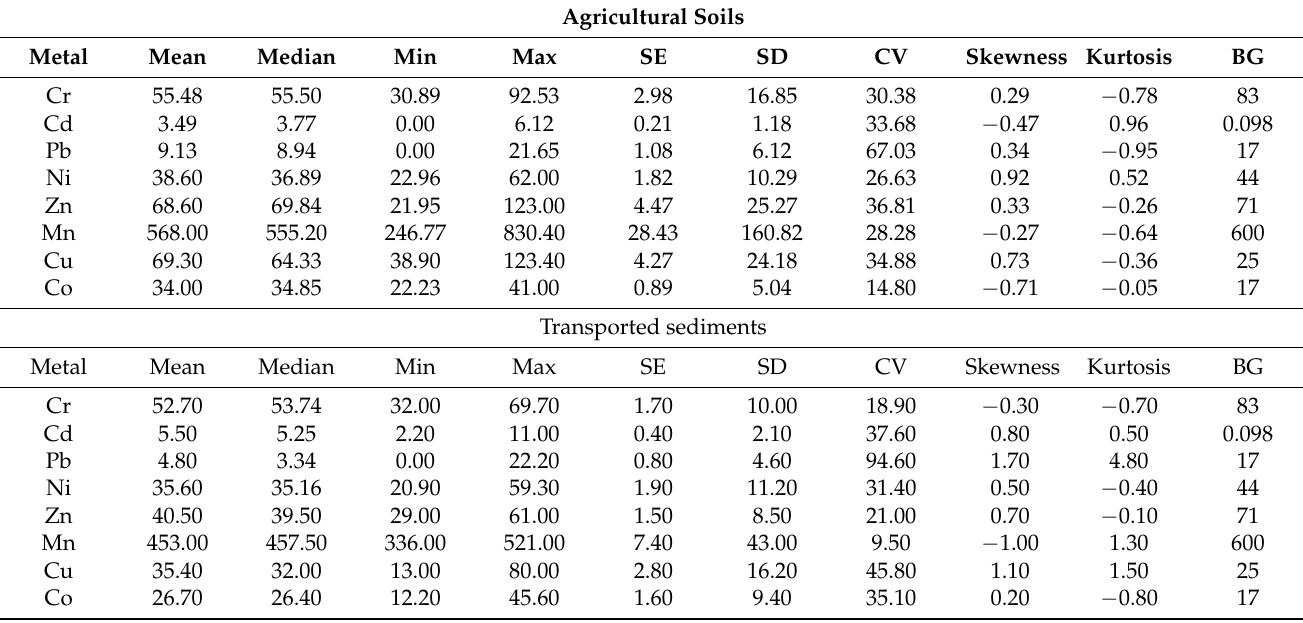
Table 3. Values of heavy metals’ concentration (mg kg − 1 ) in agricultural soils and transported sediments. SE: standard error; SD: standard deviation; CV: coefficient of variation; BG: background